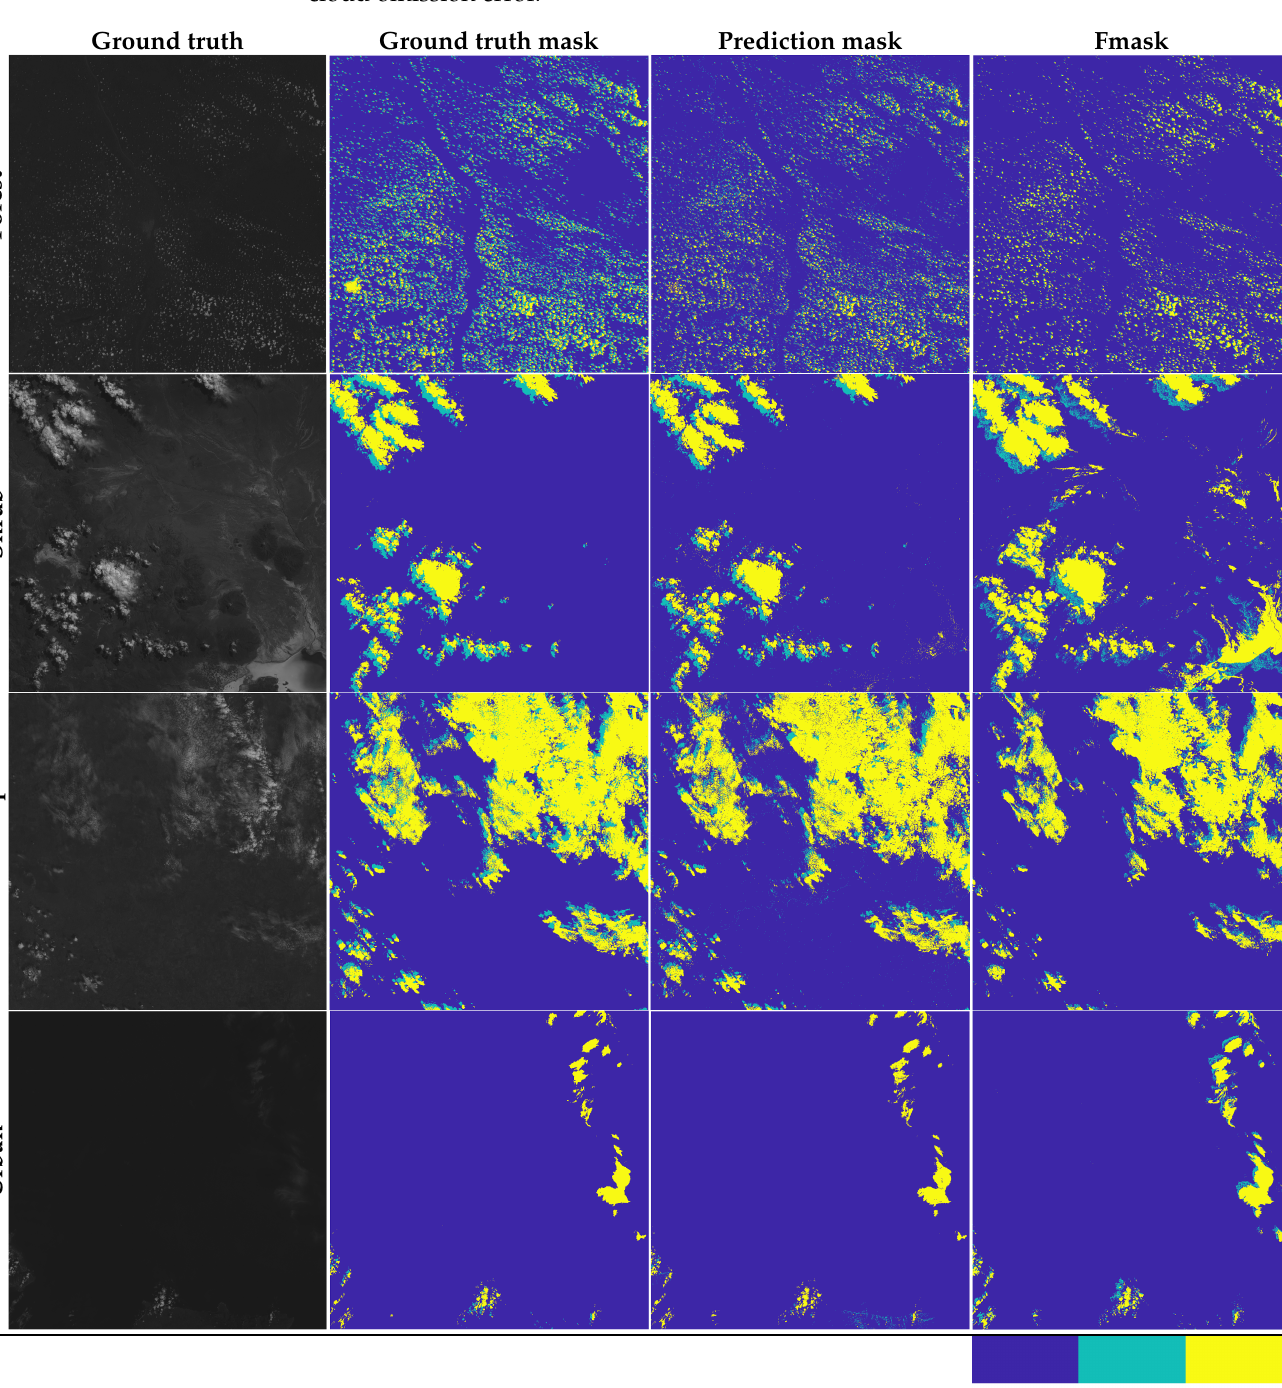
Figure 5. Sample image comparison between the validation mask, 88Mdl_5index_sample4 model predicted mask and Fmask. Each row displays an image with a certain type. The first column represents the ground truth image and the second column represents the ground truth mask, which is manually generated by expert. The third column represents the model prediction results and the fourth column displays the Fmask application